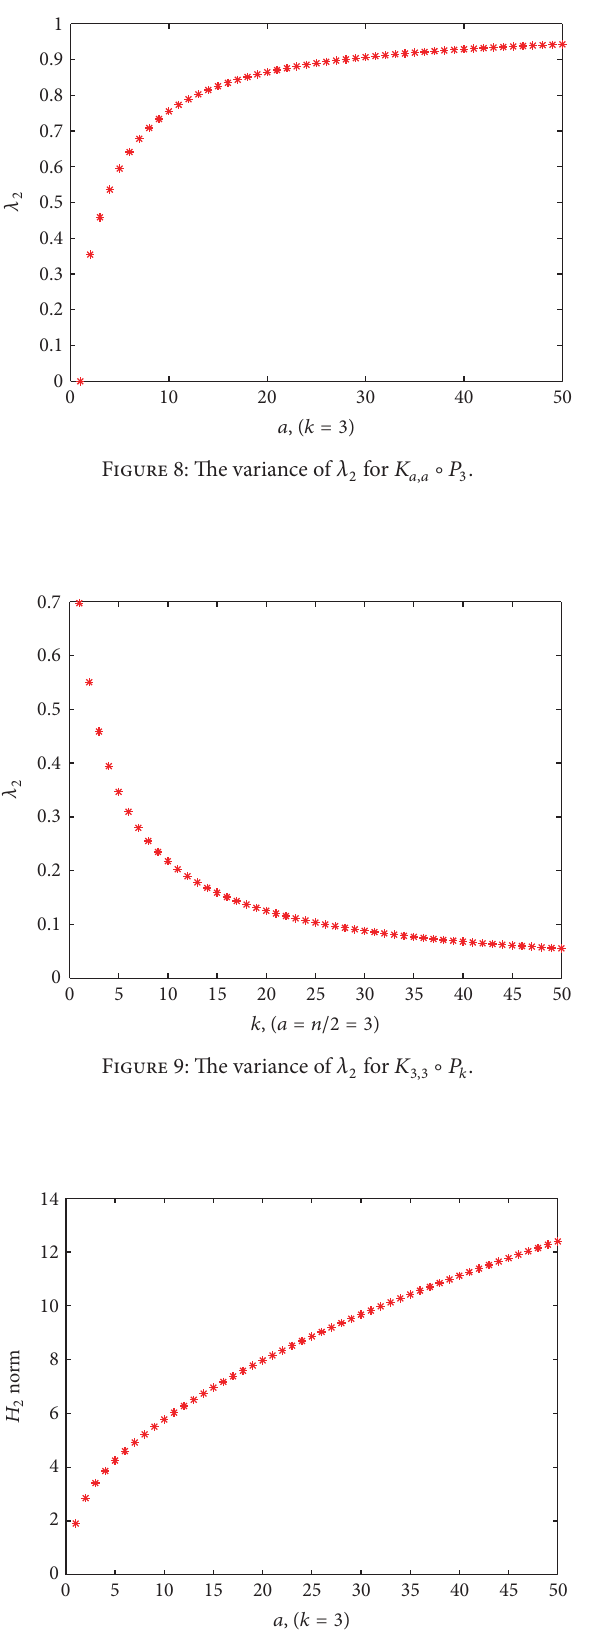
Figure 10: The variance of 𝐻 2 norm for 𝐾 𝑎,𝑎 ∘ 𝑃 3 .